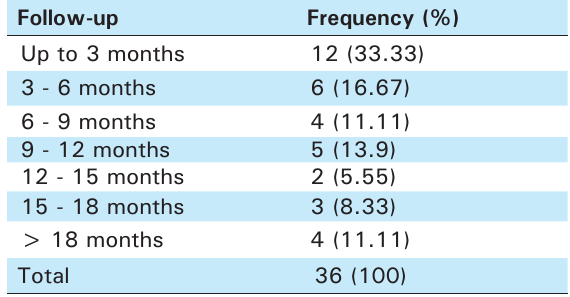
Table 4. Duration of follow up.